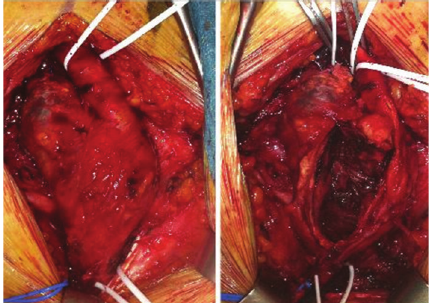
Figure 2: Intraoperative image of the true giant right profunda femoral artery aneurysm.